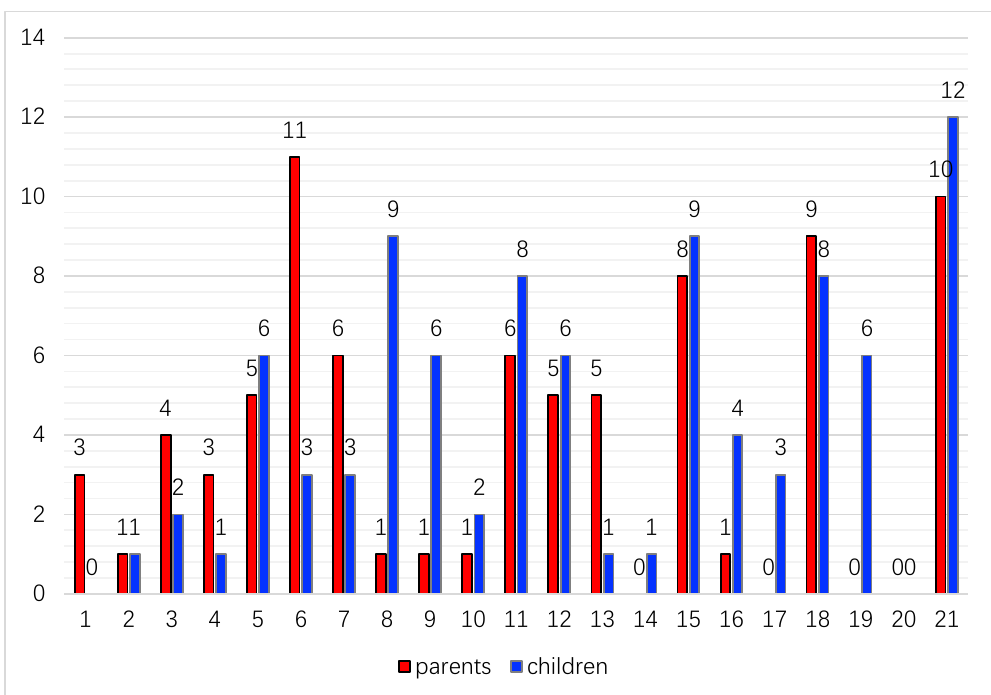
Figure 1. Frequency count of each item of the PMP-C being selected as desire-to-change activity